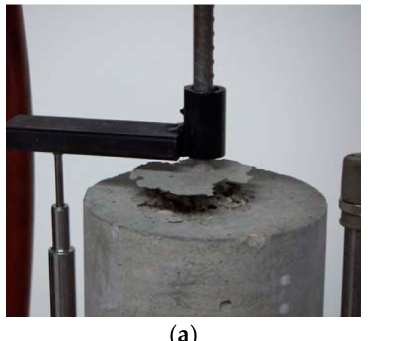
Figure 6. Concrete tensile failure: ( a ) specimen S21; ( b ) specimen S43.